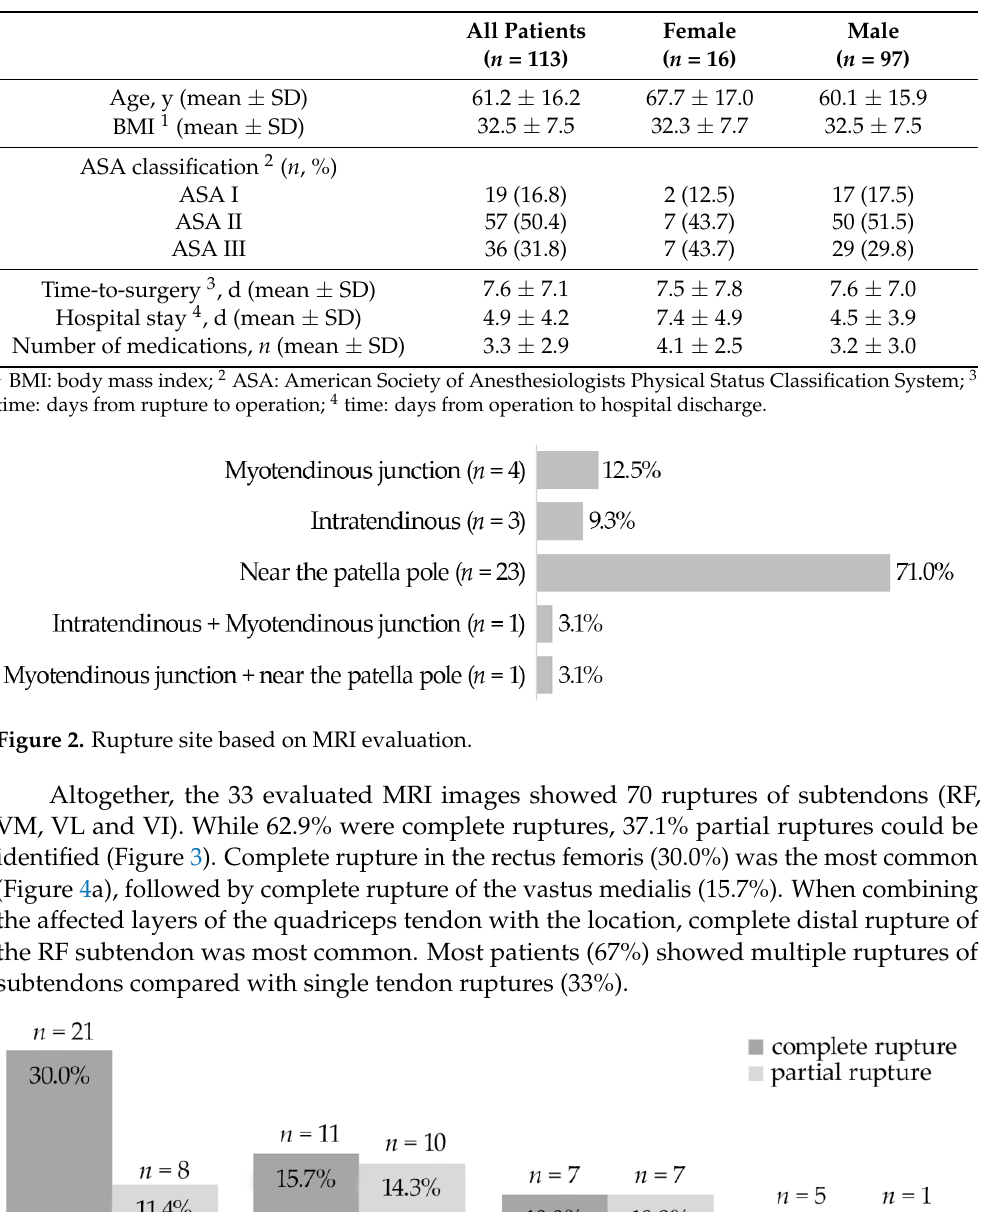
Table 1. Demographic data and patients’ related characteristics.